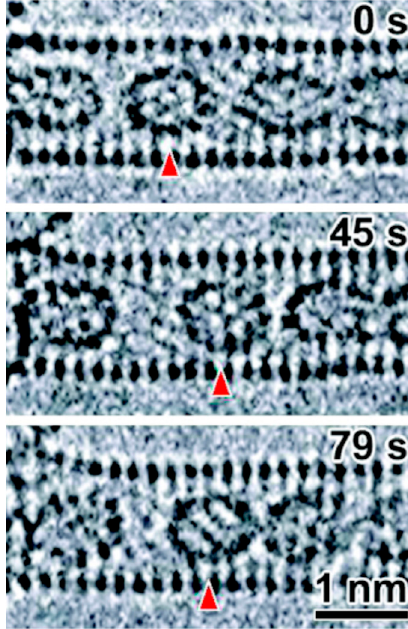
Figure 10. Aberration-corrected TEM images of D 5d -C 80 fullerene molecules inside (18,1) SWNT, from work by Suenaga et al. Reproduced with permission from [78]. American Chemical Society, 2007. Triangles indicate encapsulated molecule undergoing orientational changes.